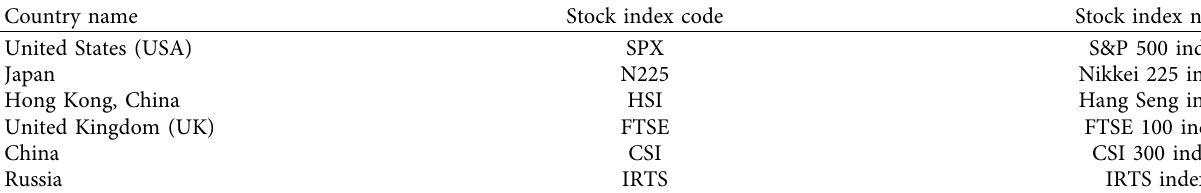
Table 1: Notations of stock indices.